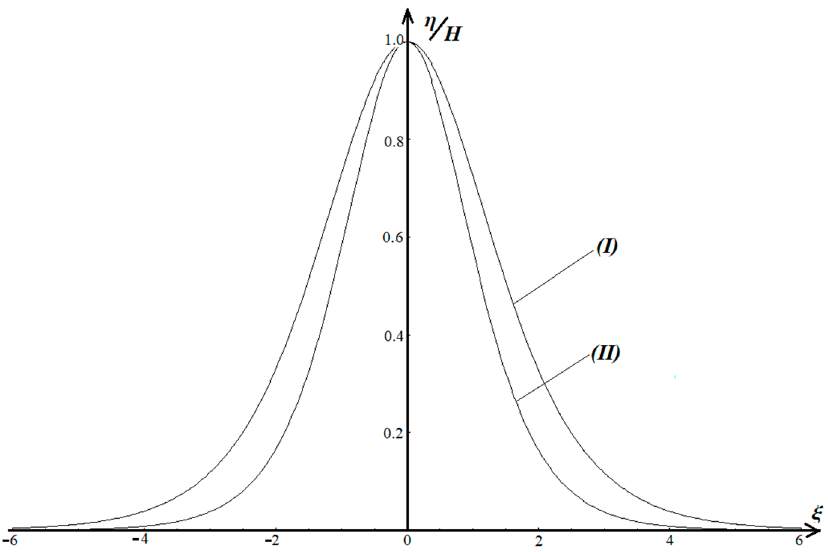
Figure 1. Solitary waves for H = 0.8 , (I) and (II) FN and BM models,